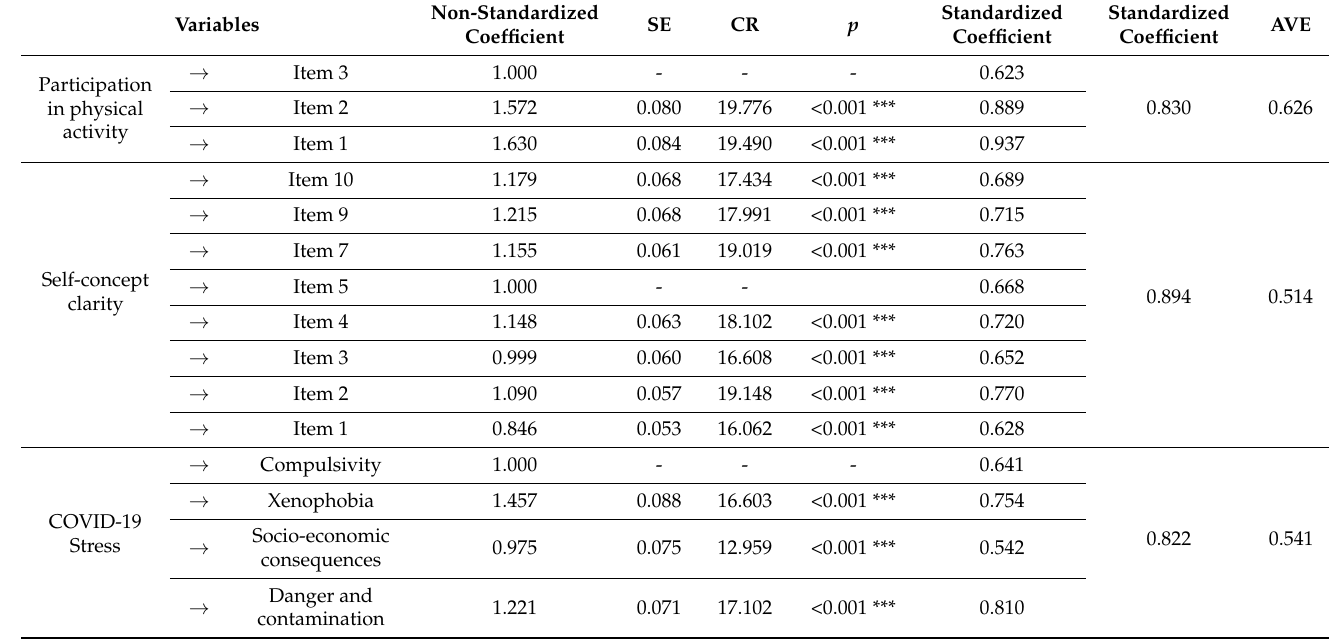
Table 3. Results of the confirmatory factor